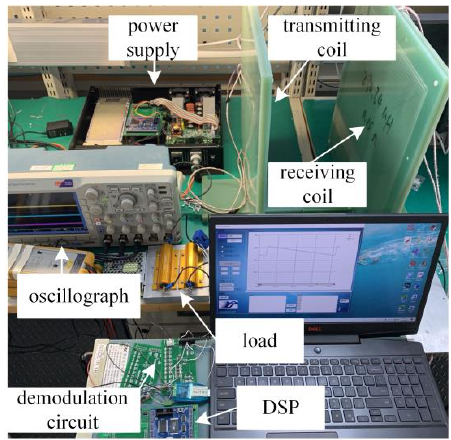
Figure 9. Experimental setup. Table 3. Demodulation circuit parameters.